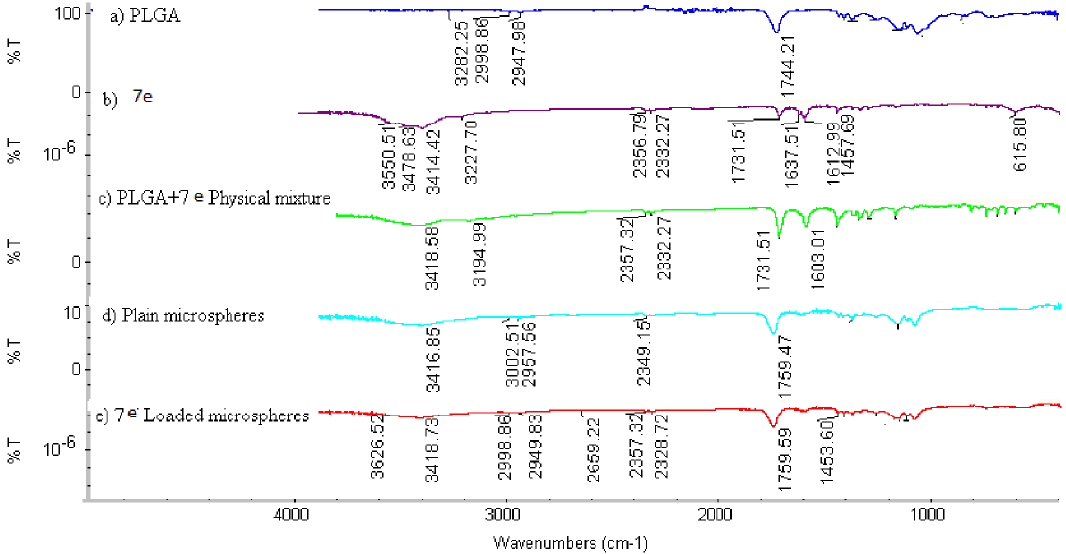
Fig 9. FT-IR spectrum of a) PLGA, b) Pure 7e, c) Physical mixture of the PLGA + 7e, d) Plain microspheres, and e) 7e-